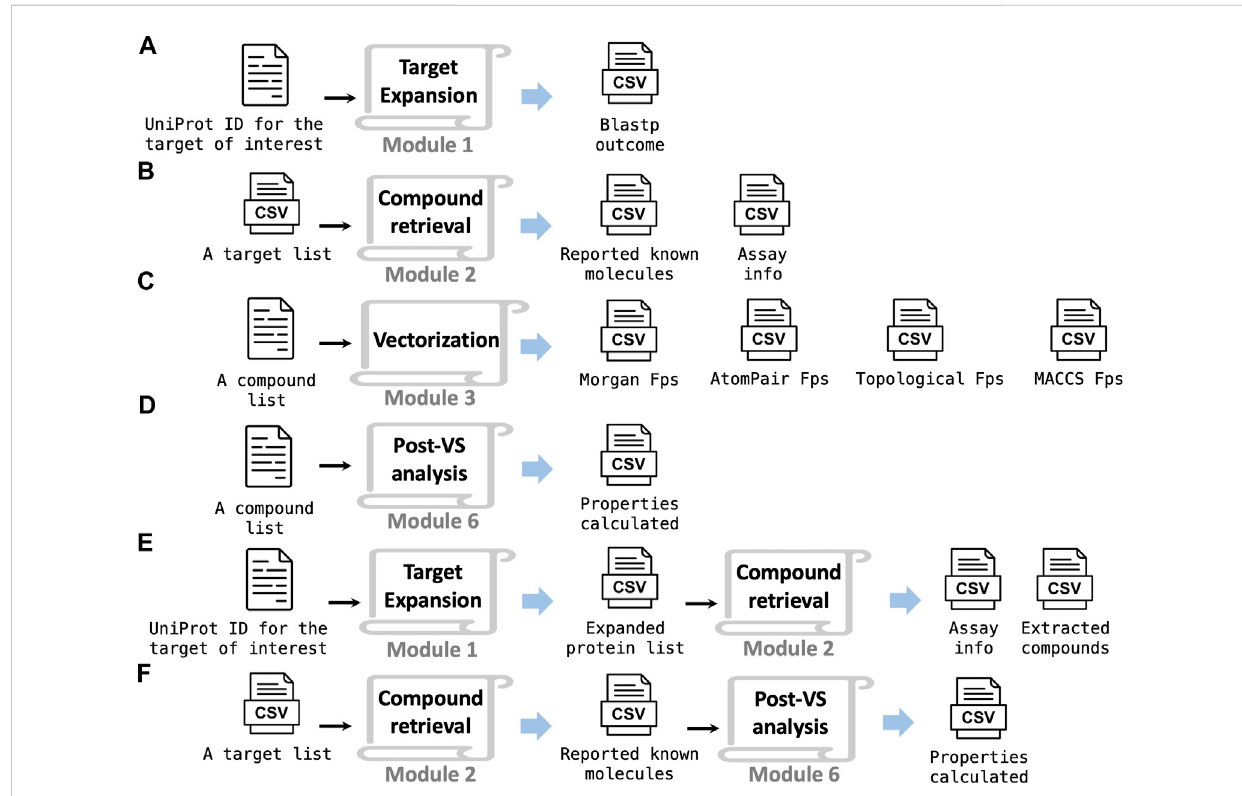
FIGURE 5 This platform has the fl exibility for multi-purpose adaptation. Using an individual module (A – D) or acombination ofmodules (E, F) to realize various